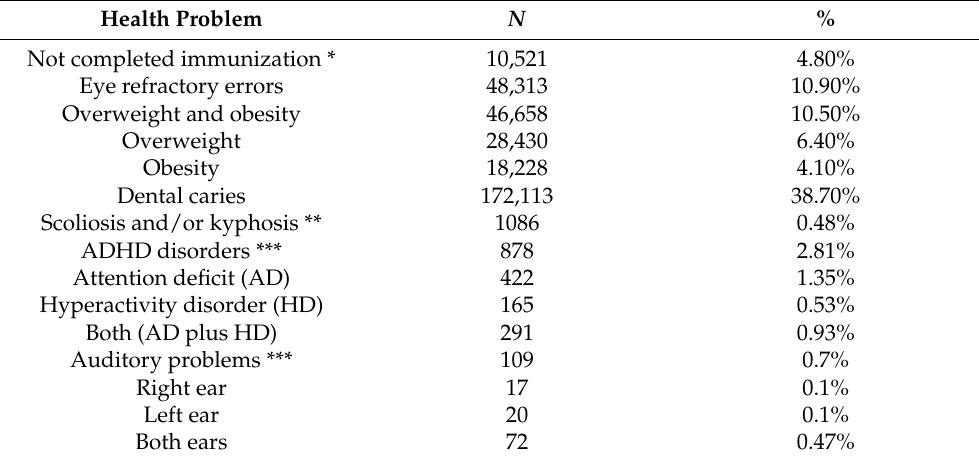
Table 2. The prevalence of health problems among screened primary school students in KSA ( N = 444,259).